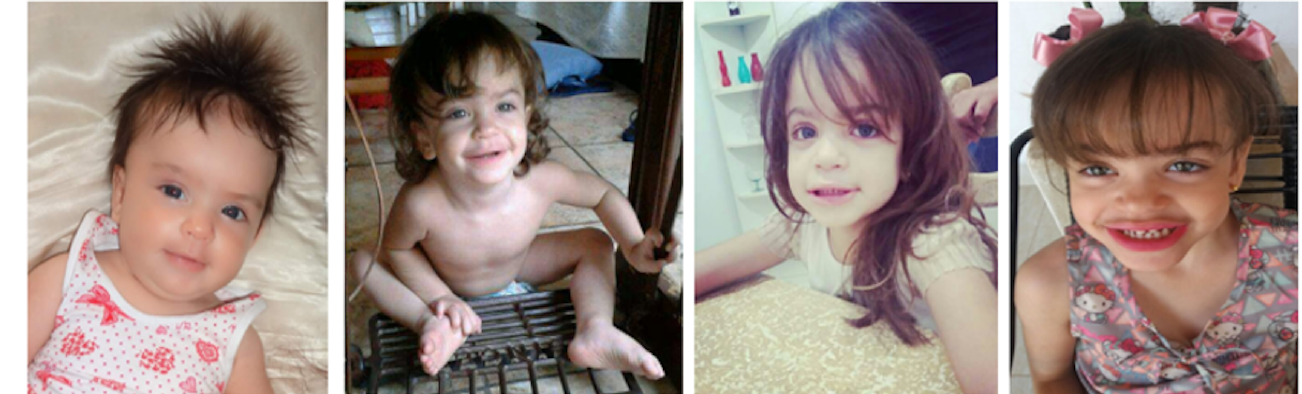
Figure 1. Patient at one, two, three and five years of age, showing the coarse facial features which are common in